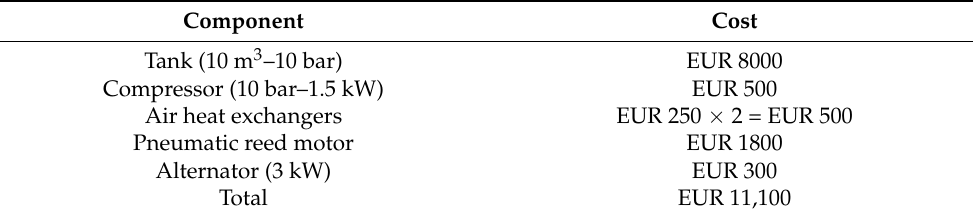
Table 4. The purchase costs of the main components of the micro-CAES + TES system.